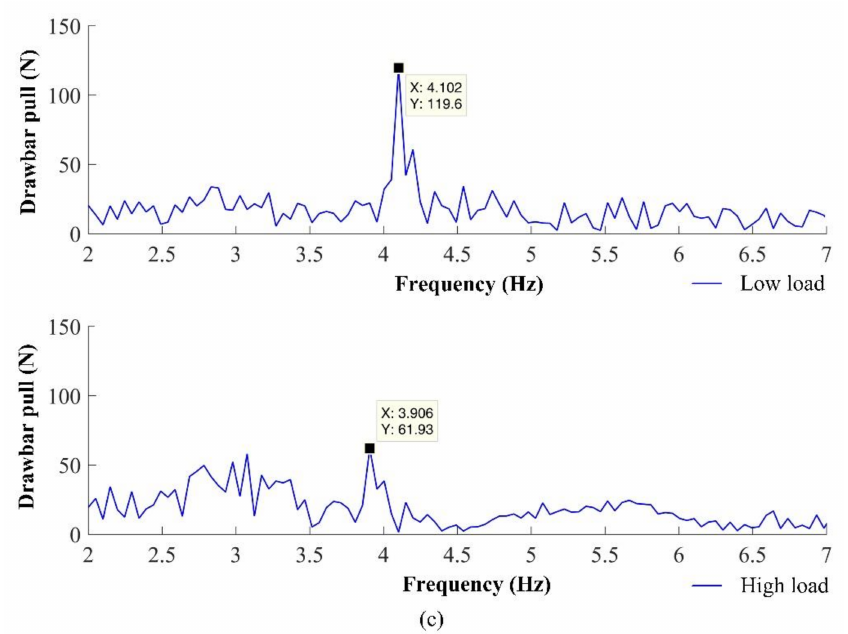
Figure 9. FFT of drawbar pull of the test tractor with different driving wheels with a low and high load: ( a ) standard tires; ( b ) spike tires; ( c ) blade